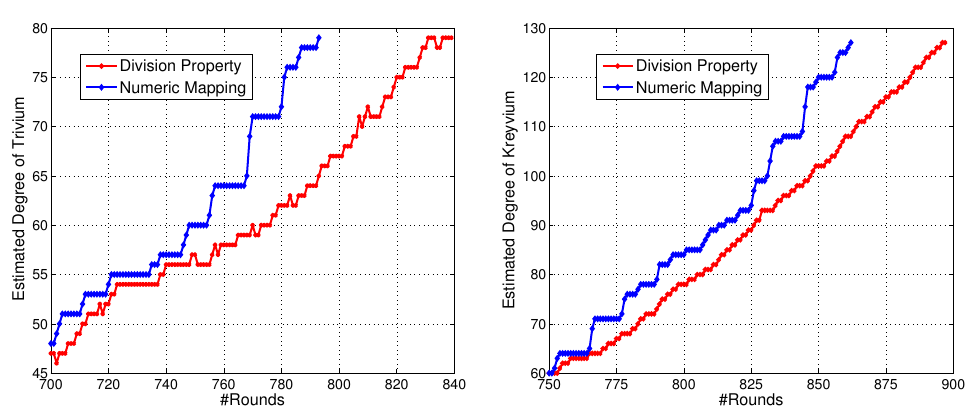
Figure 3: Estimated degrees of Trivium and Kreyvium derived by division property and numeric